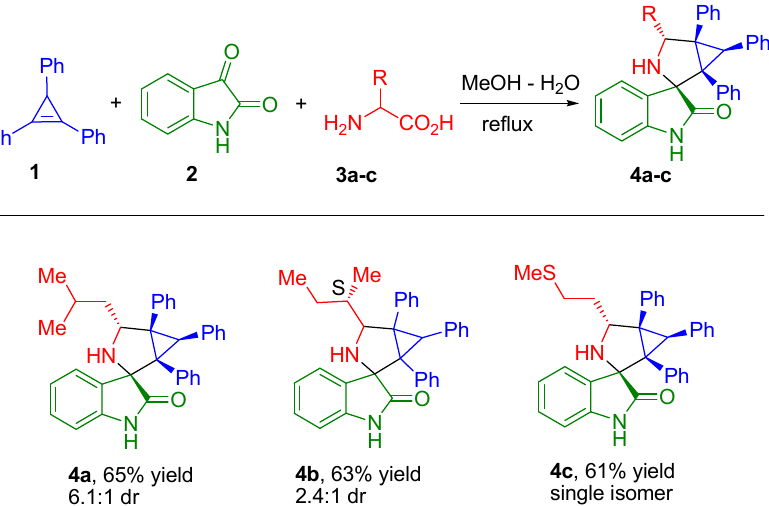
Figure 4. Synthesis of spiro-fused [3-azabicyclo[3.1.0]hexane]oxindoles 4a , 4b , and 4c . Synthesized compounds containing spiro-fused 3-azabicyclo[3.1.0]hexane and oxindole moieties, by means of 1,3-dipolar cycloaddition reaction of appropriately substituted cyclopropene 1 to azomethine ylides generated in-situ from isatin 2 and corresponding α -amino acids 3a- с .